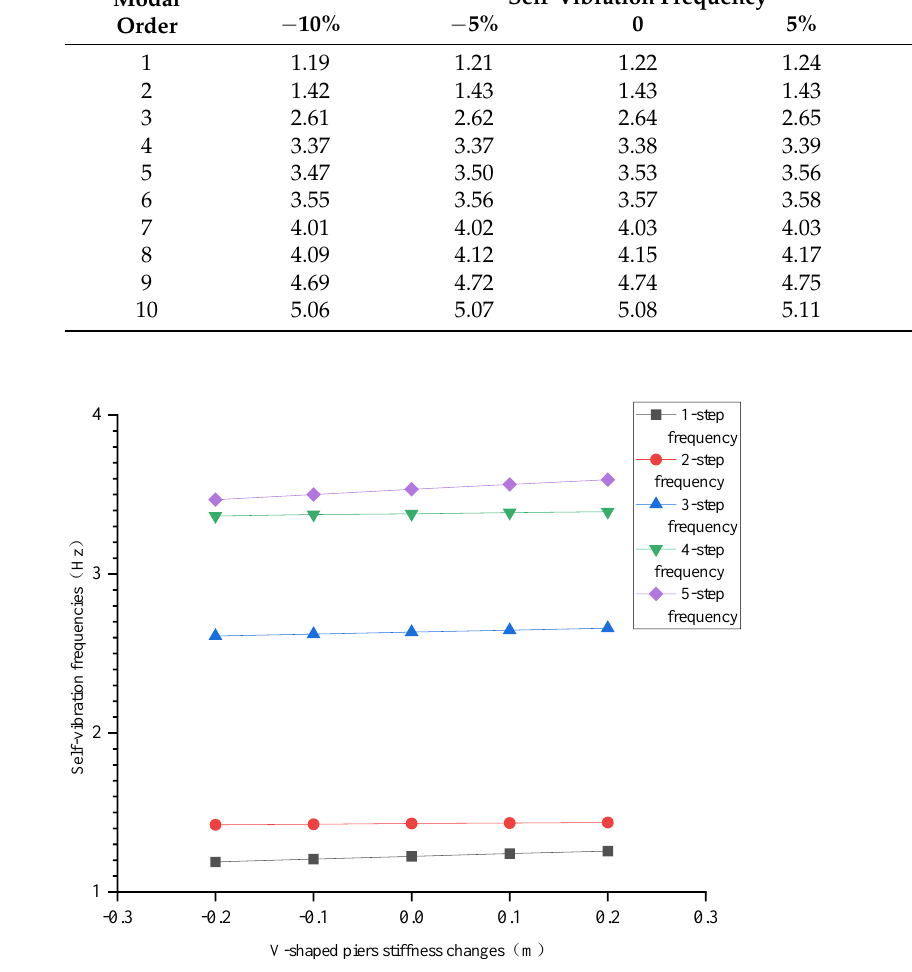
Figure 12. Self-vibration frequencies for different V-shaped pier stiffnesses of Structure I.